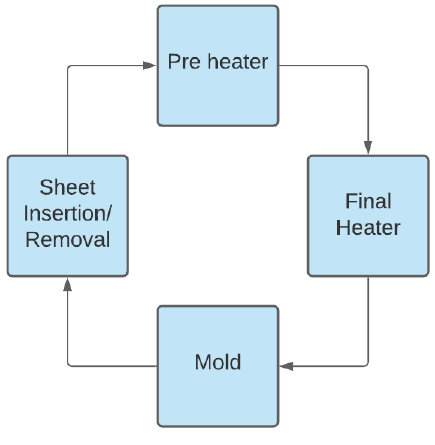
Figure 3. Thermoforming process.